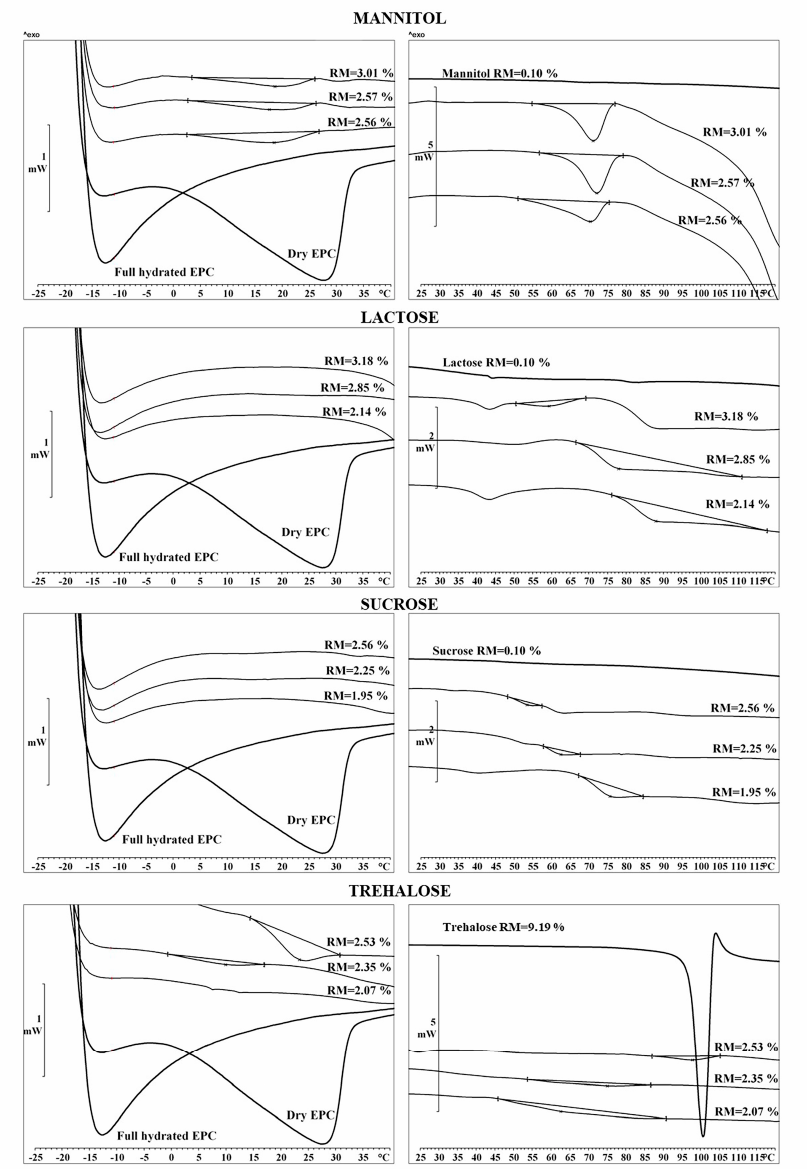
Figure 7. DSC thermograms of dry EPC, full hydrated EPC (fresh liposomes) and EPC in lyophilized liposomes. Influence of additives and remaining moisture (RM) on gel-to-liquid crystalline phase transition (left panel) and on glass transition temperature (right panel).